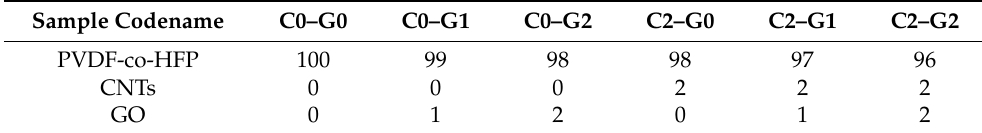
Table 1. Formulation of the samples investigated (amounts given in wt